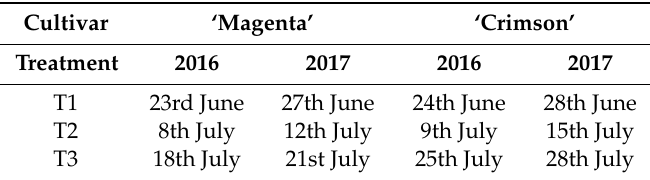
Table 1. Dates of salicylic acid (SA), acetyl salicylic acid (ASA) and methyl salicylate (MeSa)